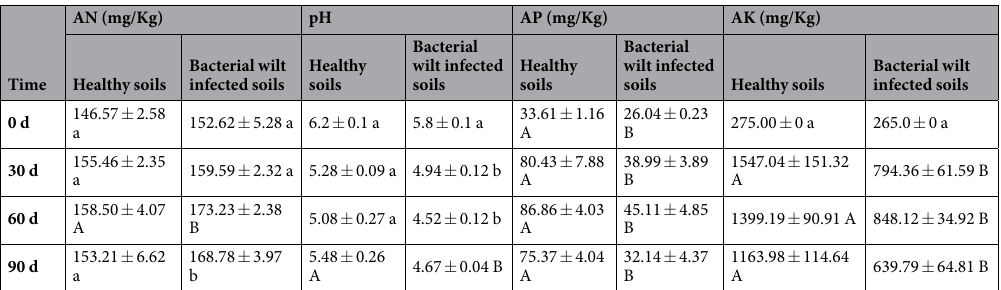
Table 2. Soil chemical properties. All data are presented as the mean ± SE. AK: available potassium content; AN: available nitrogen content, AP: available phosphorous content. Different capital letters and lowercase letters in the same line indicate very significant ( p < 0.01) and significant ( p < 0.05) difference between healthy and bacterial wilt infected soils, respectively.